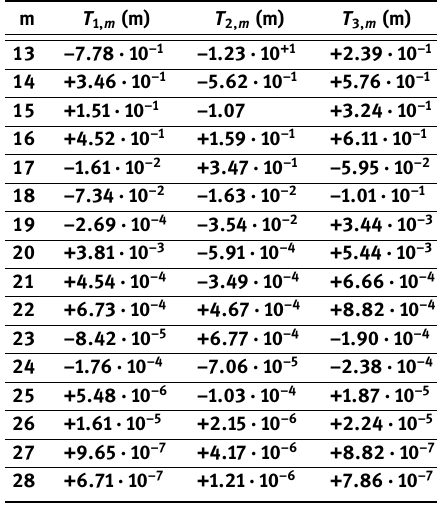
Table 3. Example of the series terms T , j = 1, 2, 3, of the Taylor j , m series expansions Eq. (11); m : Taylor series